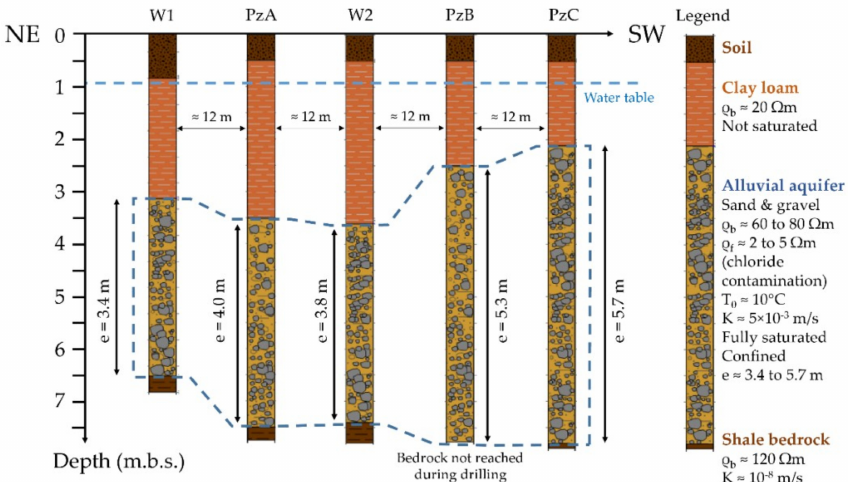
Figure 2. NE-SW cross-section of the investigated area presenting the underlying geology and hydrogeophysical parameters (modifier after [37]). ρ is the electrical resistivity; the subscripts b and f respectively stand for bulk and fluid (groundwater); K is the hydraulic conductivity; T 0 is the ambient groundwater temperature; e is the aquifer thickness; and m.b.s. is meters below